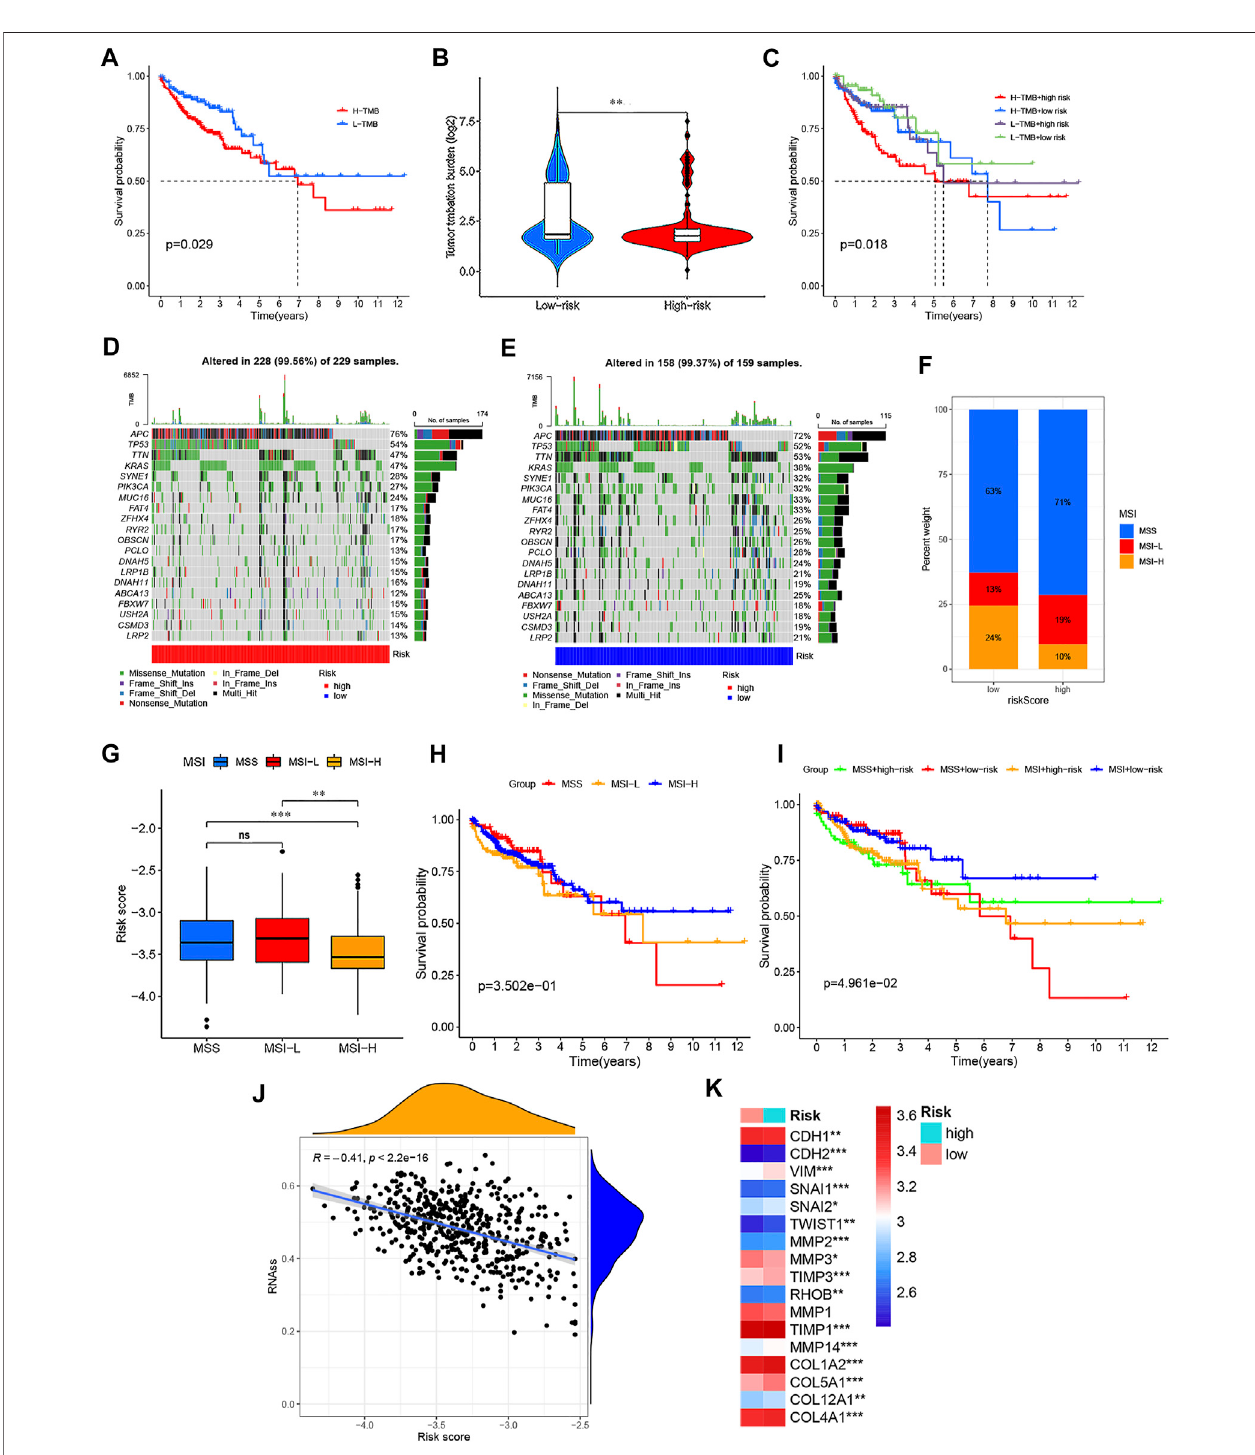
FIGURE10| ComprehensiveanalysisofthePRGsignatureinCRC. (A) Kaplan – Meiercurvesforthehigh-andlow-TMBwiththecut-offvalueof2.421of399CRC patients in TCGA cohorts. (B) TMB difference in the high- and low-risk groups. (C) Kaplan – Meier curves for CRC patients in TMB and risk score subgroups. (D,E) Waterfall plot of somatic mutation features established with the high- and low-risk groups. (F,G) Correlation between two risk groups and MSI. (H) Kaplan – Meier curves for MSS, MSI-L, and MSI-H of CRC patients. (I) Kaplan – Meier curves for CRC patients in MSS, MSI-L, and MSI-H and risk score subgroups. (J) Correlation betweentworiskgroupsandCSCindex. (K) ThermogramshowsvariationsinthemRNAexpressionofEMT-relatedgenesbetweenthetworiskgroups.* p < 0.05;** p < 0.01; and *** p < 0.001.